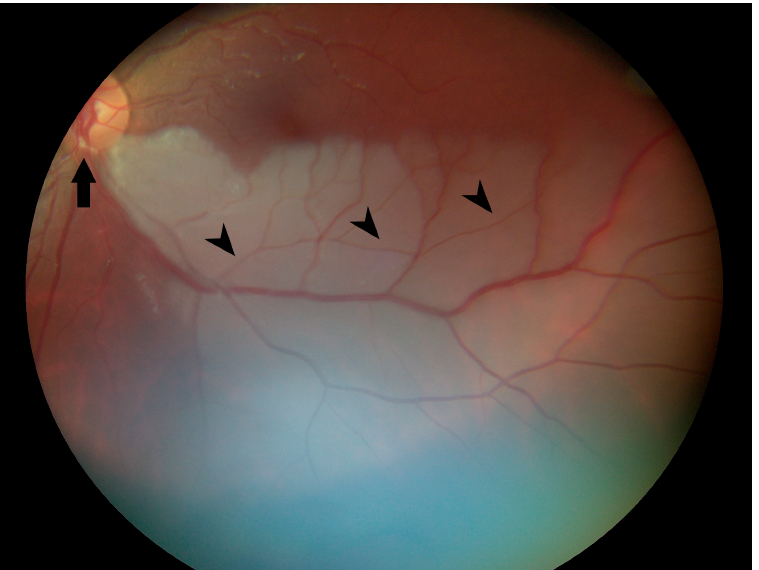
Figure 2. Color fundus photograph of the left eye at presentation shows retinal whitening of the inferior fundus consistent with diagnosis of branch retinal artery occlusion. Note the yellow refractile body within the inferior arterial arcade at the disc margin (arrow) and attenuation of peripheral arterioles (arrowheads).